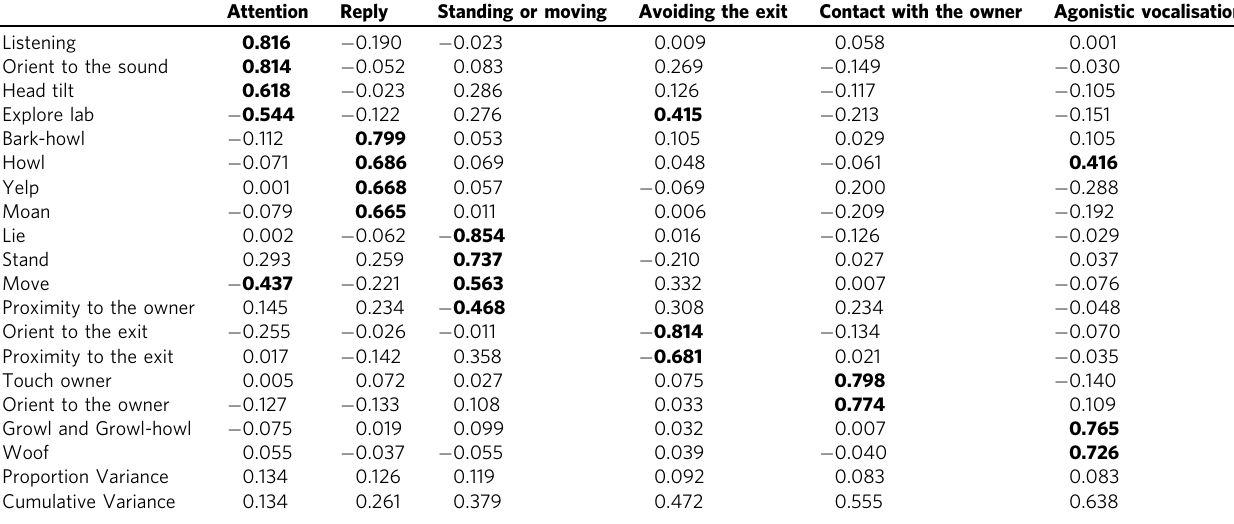
Table 1 Distribution of the coded behaviour variables between the